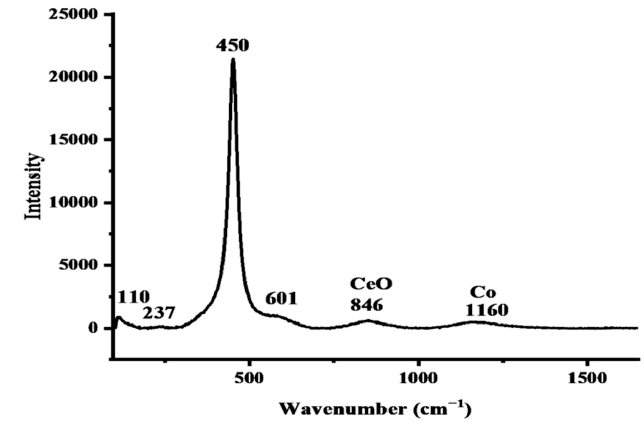
Figure 5. Raman analysis of the synthesized Co/CeO 2 /C nanocomposite.